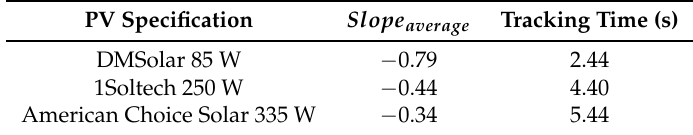
Table 1. Numerical result for the proposed hotspot detection algorithm using different PV specifications: (a) 85 W; (b) 250 W; and (c) 335 W.